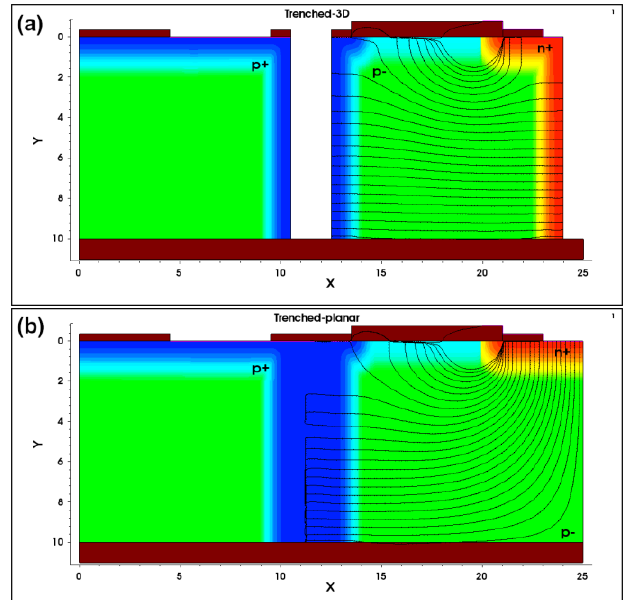
Figure 6. 2D structures used for numerical simulations of ( a ) the Trenched-3D and ( b ) Trenched- planar sensors. The figures also show the drift lines based on the simulated electric field. sensors. The figures also show the drift lines based on the simulated electric